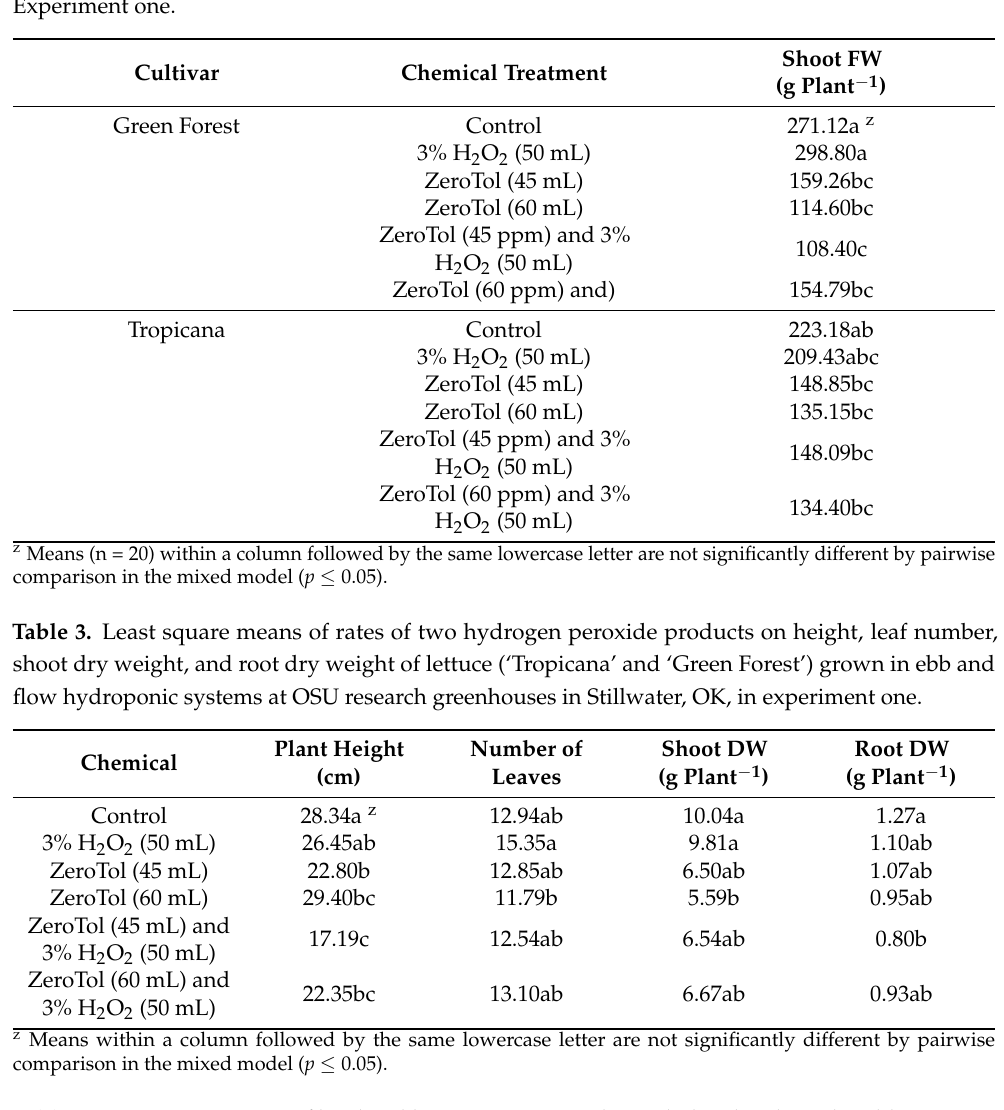
Table 4. Least square means of basil and lettuce on SPAD index and plant height and width grown in ebb and flow hydroponic systems at OSU research greenhouses in Stillwater, OK, in experiment